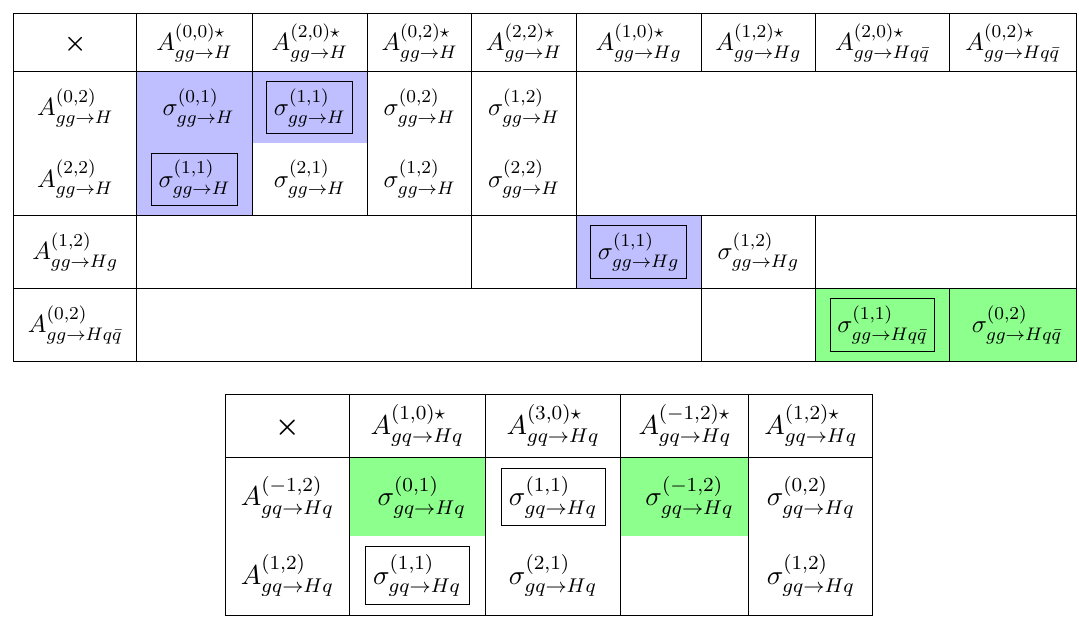
Table 1 . Summary of contributing amplitudes to the weak corrections to Higgs inclusive production involving one (bottom table) and two (top table) initial-state gluons, for various perturbative orders. The results reported in this work are highlighted with a green background, while those addressed in refs. [7, 9] are denoted in blue. Together, these form the complete (cid:27) (1 ; 1)